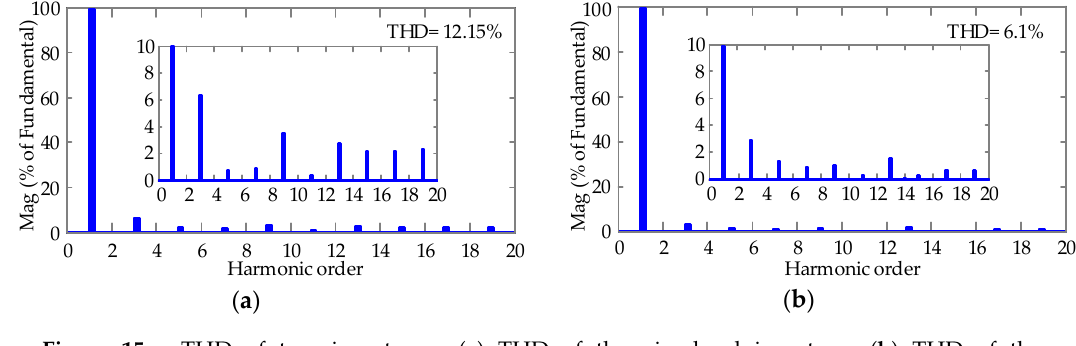
Figure 15. THD of two inverters. ( a ) THD of the nine-level inverter. ( b ) THD of the seventeen-level